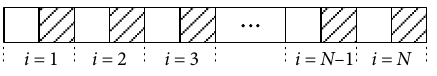
Figure 4: Example of normal chromosome.